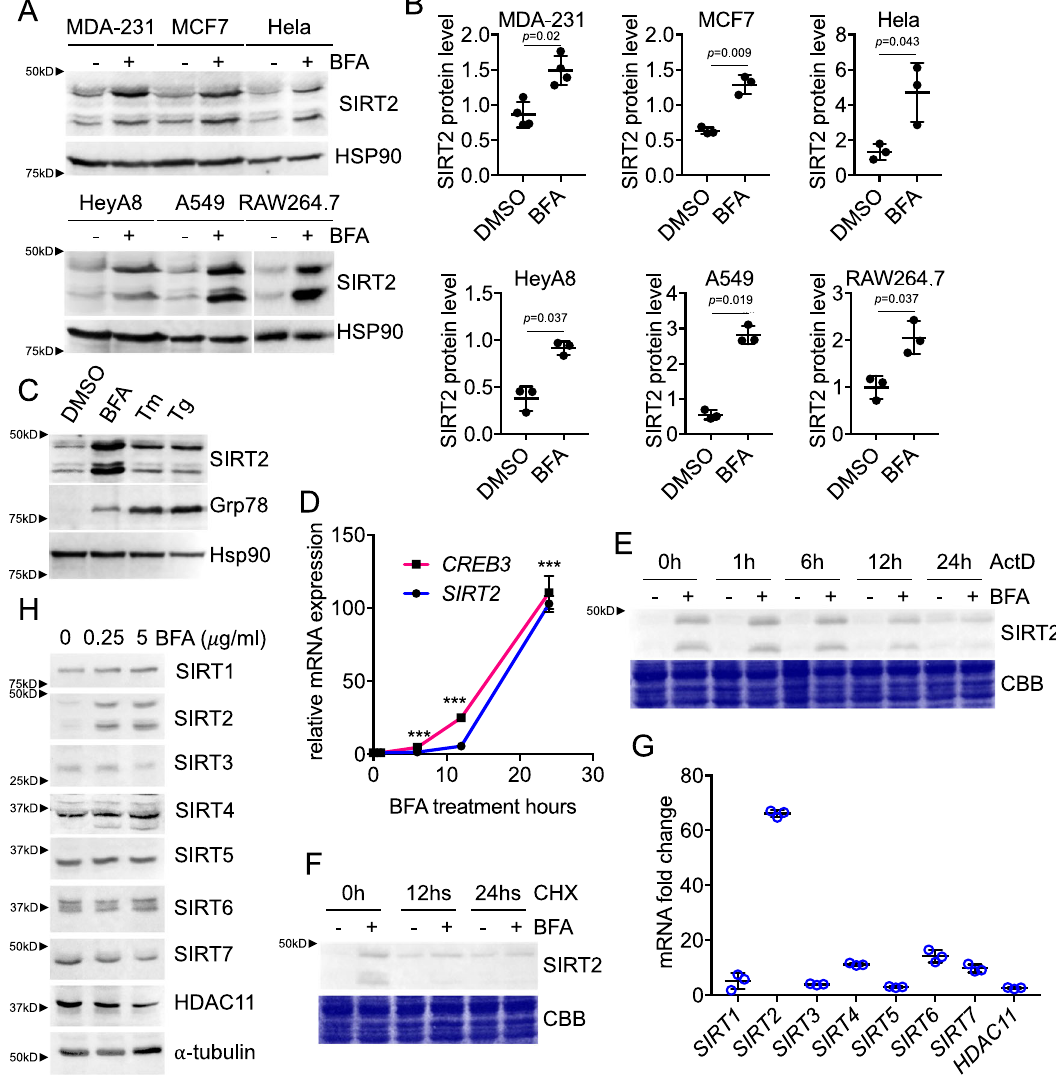
Fig. 1 | Golgi stress transcriptionally upregulates SIRT2. A Immunoblots for SIRT2 in different cell lines treated with 5 μ g/ml BFA for 24h. HSP90 blots are shown as loading controls. Representative images from three independent experimentsareshown. B Quanti fi cationofrelativeSIRT2proteinlevelsindifferent cell lines, normalized to HSP90. Statistical evaluation was done by a paired two- tailedStudent ’ s t -test. n =3or4biologicalreplicates. C InA549cells,BFAtreatment signi fi cantly increased SIRT2 protein level, while the ER stress inducers Tunica- mycin (Tm) and Thapsigargin (Tg) only weakly induced SIRT2 expression. D RT- PCR analysis for SIRT2 and CREB3 mRNA levels in A549 cells treated with 5 μ g/ml BFA for various incubation times. mRNA was normalized to 0h. Statistical evalua- tionwasdone byanunpaired two-tailed Student ’ s t -test. n =3biologicalreplicates. E ActD chase analysis showing SIRT2 upregulation is due to mRNA upregulation, which happens primarily during 12 – 24h. A549 cells were treated with or without